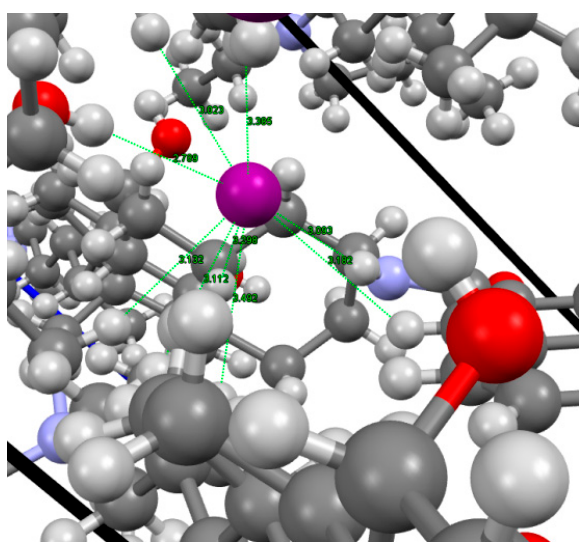
Figure 6. The shortest H-I – distances observed in the crystal structure of 1 .